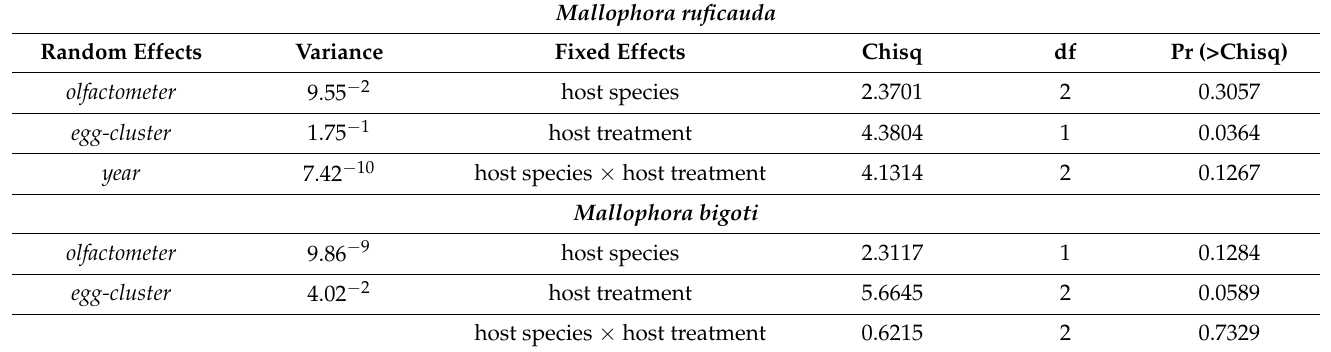
Table 3. Summary of the general results of the model for the effect of host species and treatment with tetracycline on the probability of orienting to a host for M. ruficauda (upper part) and M. bigoti (lower part). The variances of random effects are shown on the left part of the table. Results on the overall significance for fixed effects are shown on the right part of the table. Chisq: Value of the statistic. df: degrees of freedom. Pr (>Chisq): Probability that the statistic is within expected under the null hypothesis. Mallophora